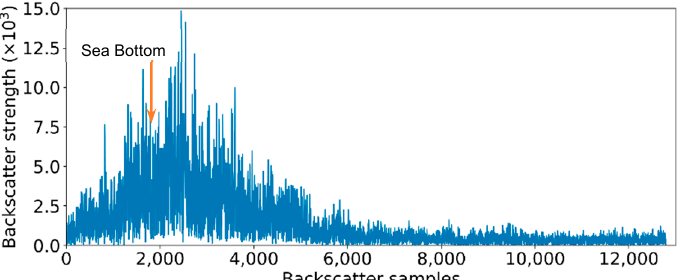
Figure 16. Backscatter strength sequence with a very large suspended object in the water Figure 16 . Backscatter strength sequence with a very large s uspended object in the water col- column umn region.